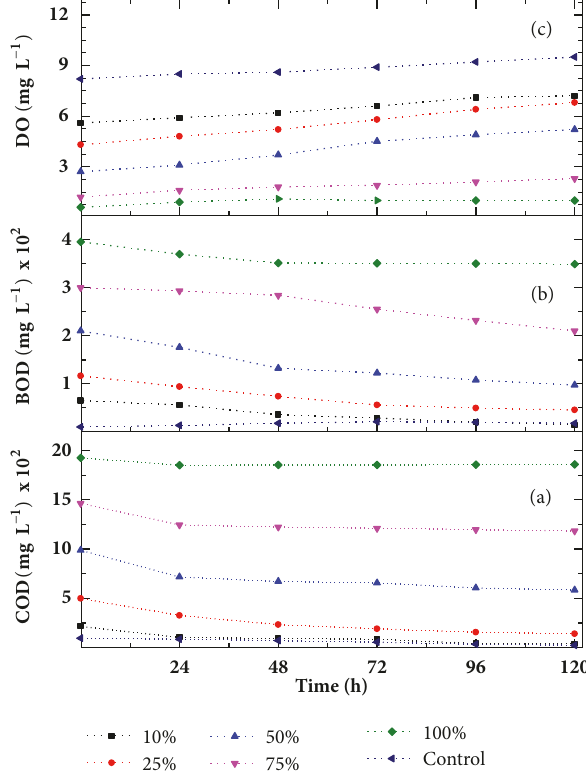
Figure 3: Variation in TDS (a), EC (b), and pH (c) as a function of time at different